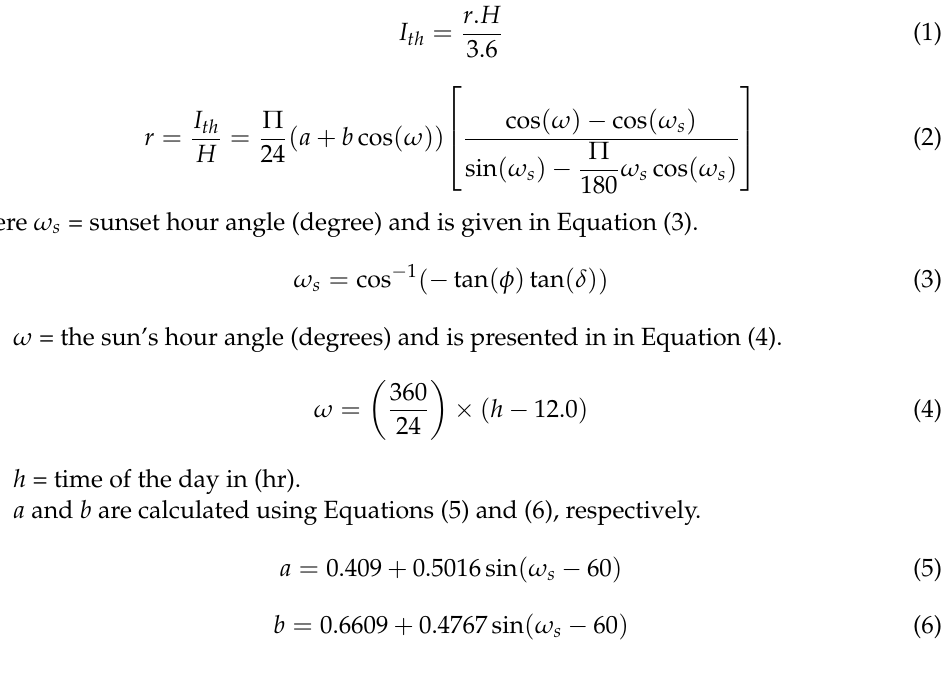
Figure 1. A typical atmospheric influence on solar radiation falling on horizontal surfaces [74]. The solar radiation that finds its way to the Earth’s atmosphere is partly diffused and partly absorbed. Furthermore, the solar radiation that reaches the Earth’s surface uninterrupted, in a straight line from the sun, is termed direct solar radiation. In the form of electromagnetic wave, the solar radiation strikes a particle, such as, for example, dust and clouds, and it is partially distributed in all directions as diffuse solar radiation. However, with regards to Equations (1)–(14) [75,76], summarized below, the total hourly solar radiation ( I th ) that strikes a horizontal surface may be used for the calculation of the daily global radiation (H) as